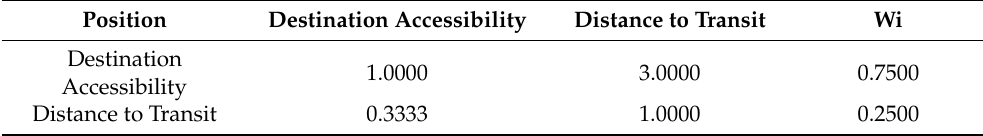
Table A12. Position Consistency ratio: 0.0000; Weight of “5D”: 0.1223; λ max: